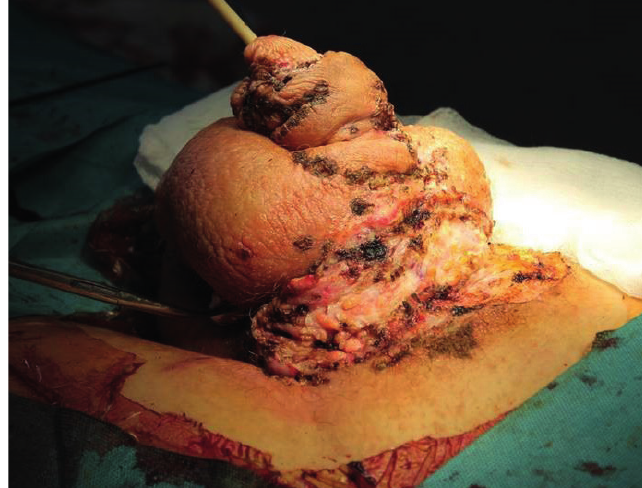
Figure 2 - View after widelocal excision of the mass.